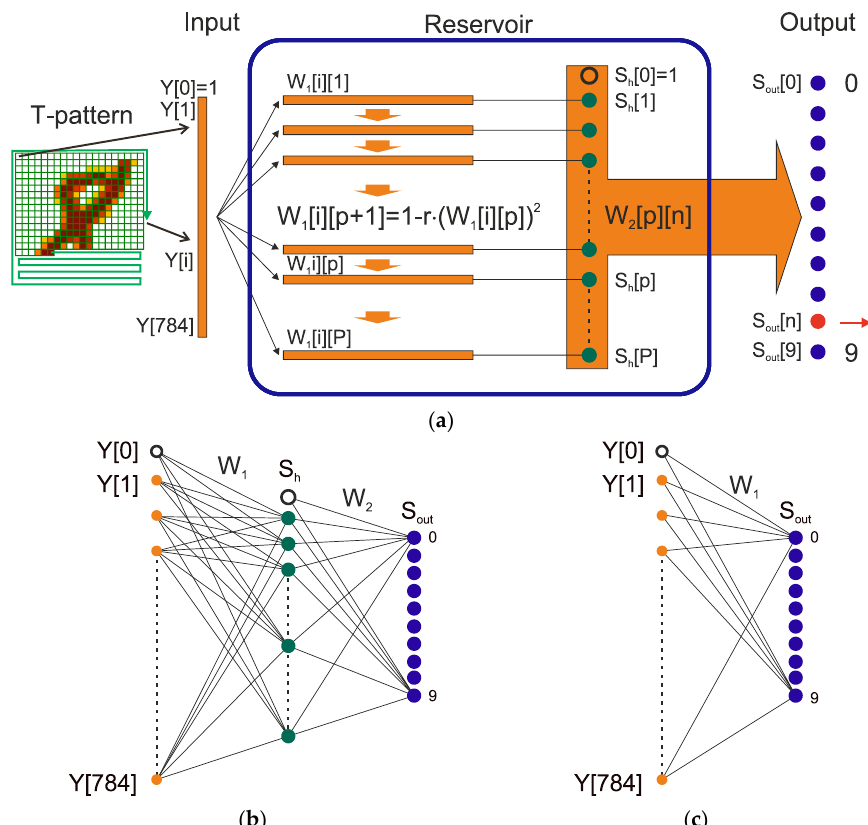
Figure 2. LogNNet architecture ( a ). Two-layer ( b ) and 1-layer ( c ) feedforward networks.